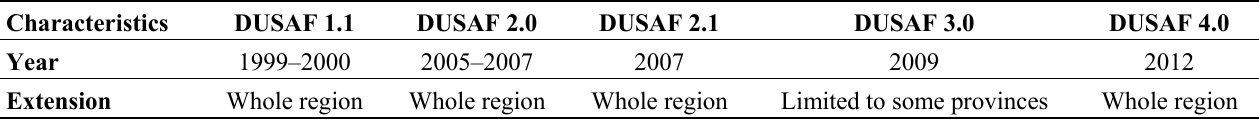
Table 3. Characteristics of DUSAF database